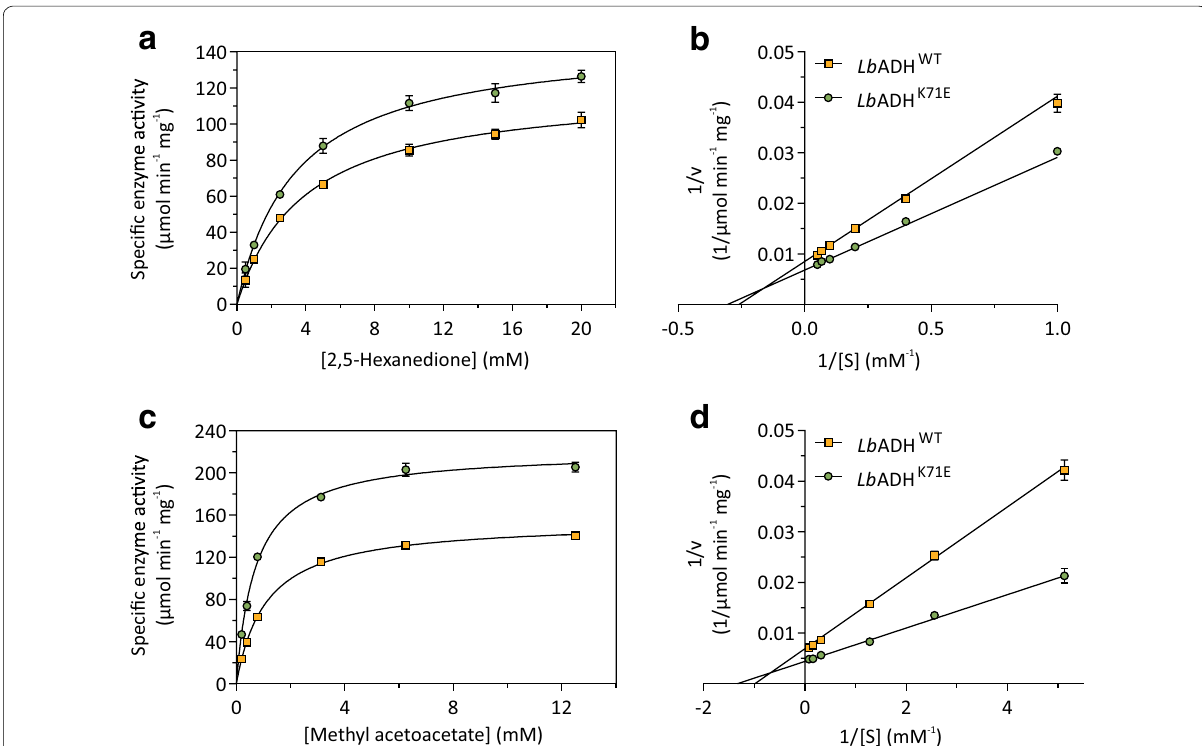
Fig. 3 Representative Michaelis–Menten plots ( a , c ) and Lineweaver–Burk plots ( b , d ) for NADPH-dependent reduction of 2,5-hexanedione to (2 R ,5 R )-hexandiol ( a , b ) and of methyl acetoacetate to ( R )-methyl 3-hydroxybutyrate ( c , d ) by purified Lb ADH WT and Lb ADH K71E . Data are mean values from three technical replicates of a single protein preparation